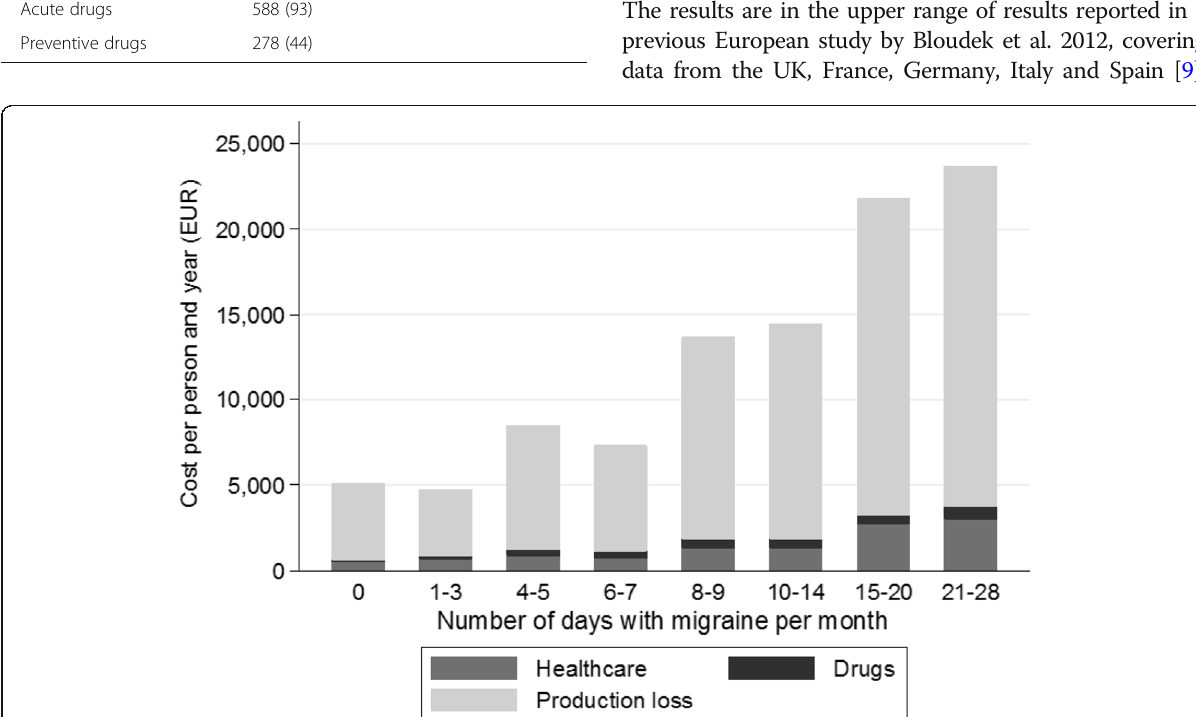
Fig. 3 Average total cost (EUR) per person and year by number of migraine days per